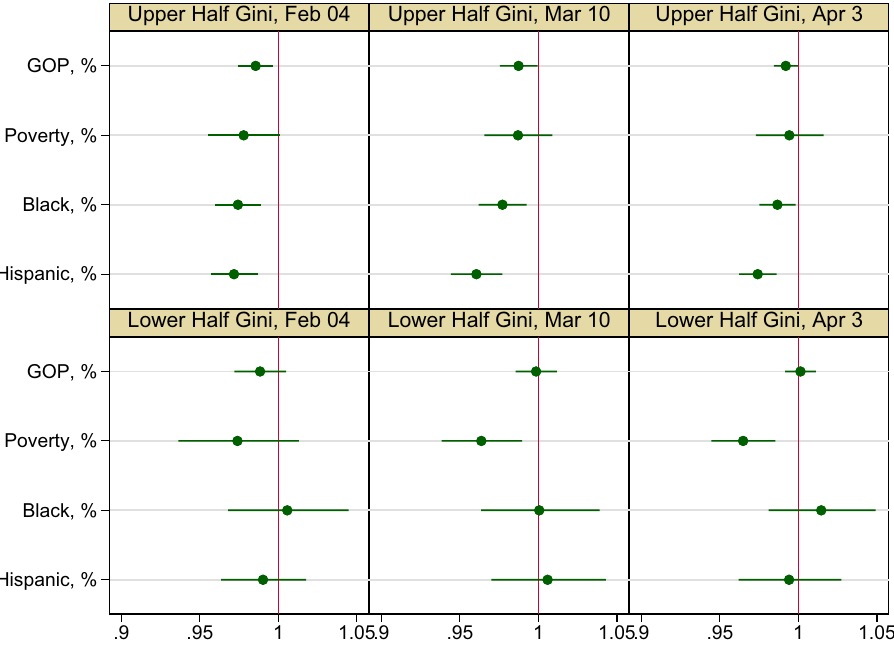
Figure 2. Odds ratios for key covariates in the fractional logit model of fully vaccinated fractions among Illinois counties as of February 4, March 10, and April 3, 2021. The odds ratios for the control variables of population density, percent population age 65 and over, percent male population, and percent uninsured population are not shown; GOP = Republican.